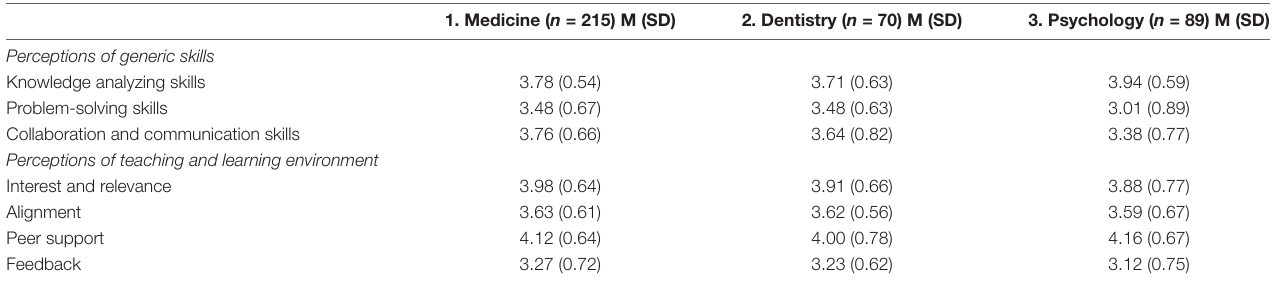
TABLE 3 | Means and standard deviations of generic skills and elements of the teaching and learning and differences among Finnish students in medicine, dentistry and psychology.